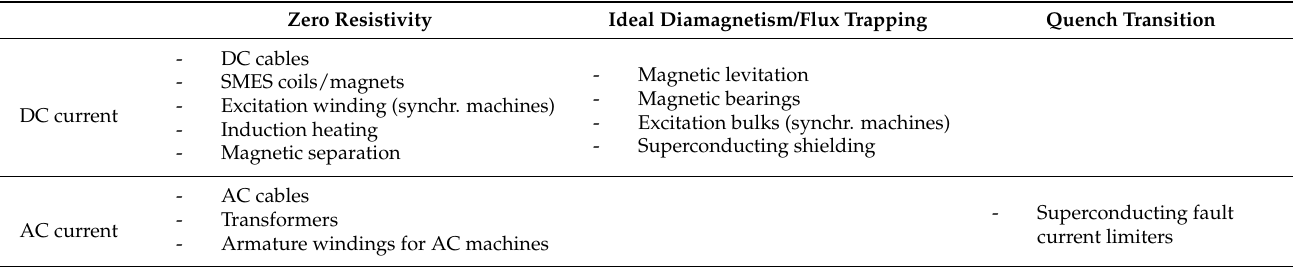
Table 2. Applications of superconductivity in energy